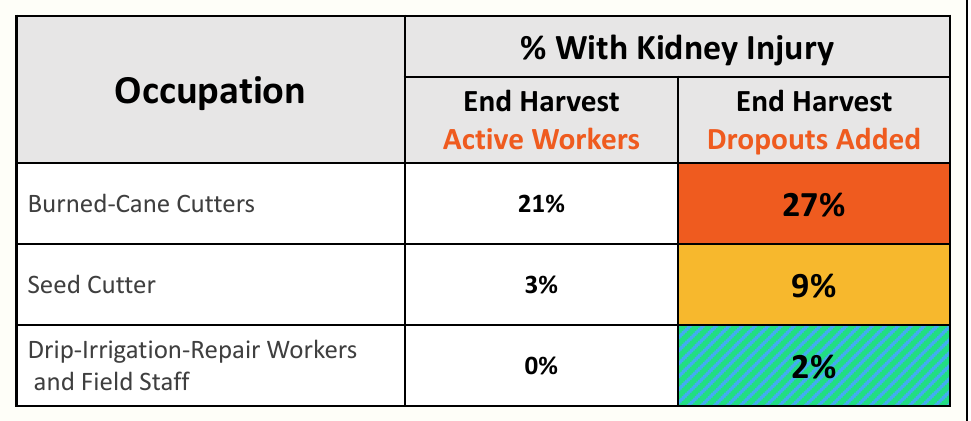
Figure 7. Baseline cross-harvest rates of kidney injury by job type with and without dropouts (adapted from reference 14)